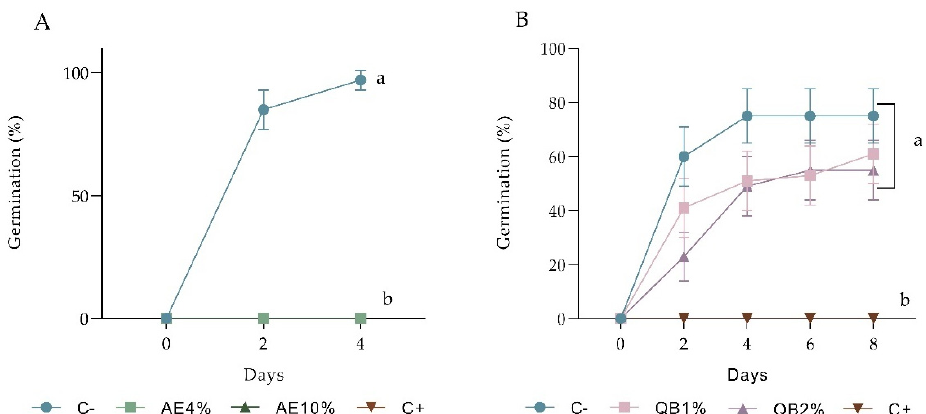
Figure 1. Pre-emergence bioassay with lettuce. Effects of ( A ) aqueous extracts (AE) (at 4 and 10%) and ( B ) saponin fraction (QB) (at 1 and 2%) on the number of germinated seeds of L. sativa at the end of 4 days and 8 days, respectively. C- represents the negative control (distilled water), and C+ represents the positive control (NaCl). Bars show 95% confidence intervals (Wilson score interval). Treatments not sharing the same letter at the final sampling time differ in germinability ( p ≤